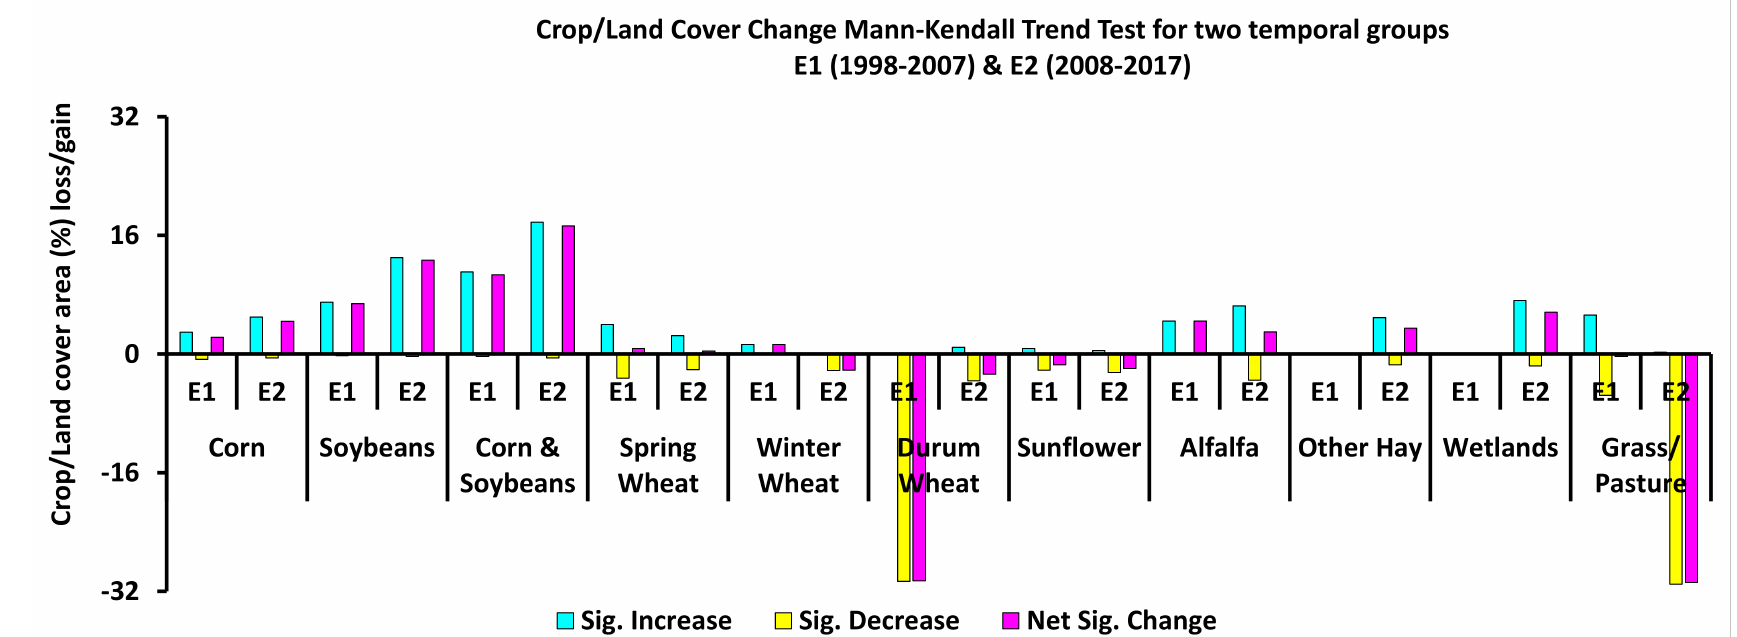
Figure 7. Mann–Kendall trend test crop / land cover area percentage (%) significant changes ( p < 0.05) using CDL data two epochs (E1 = 1998–2007 and E2 = 2008–2017) for the North Dakotan portion of the US–PPR. Significantly increased (gains in cyan), significantly decreased (losses in yellow), and net change (magenta) trends are presented for each crop / land cover. Note the grass / pasture and combined corn and soybeans exhibit opposite directions and larger magnitude trends. Other hay and wetlands categories have complete data only for the second epoch. Details are presented in Table